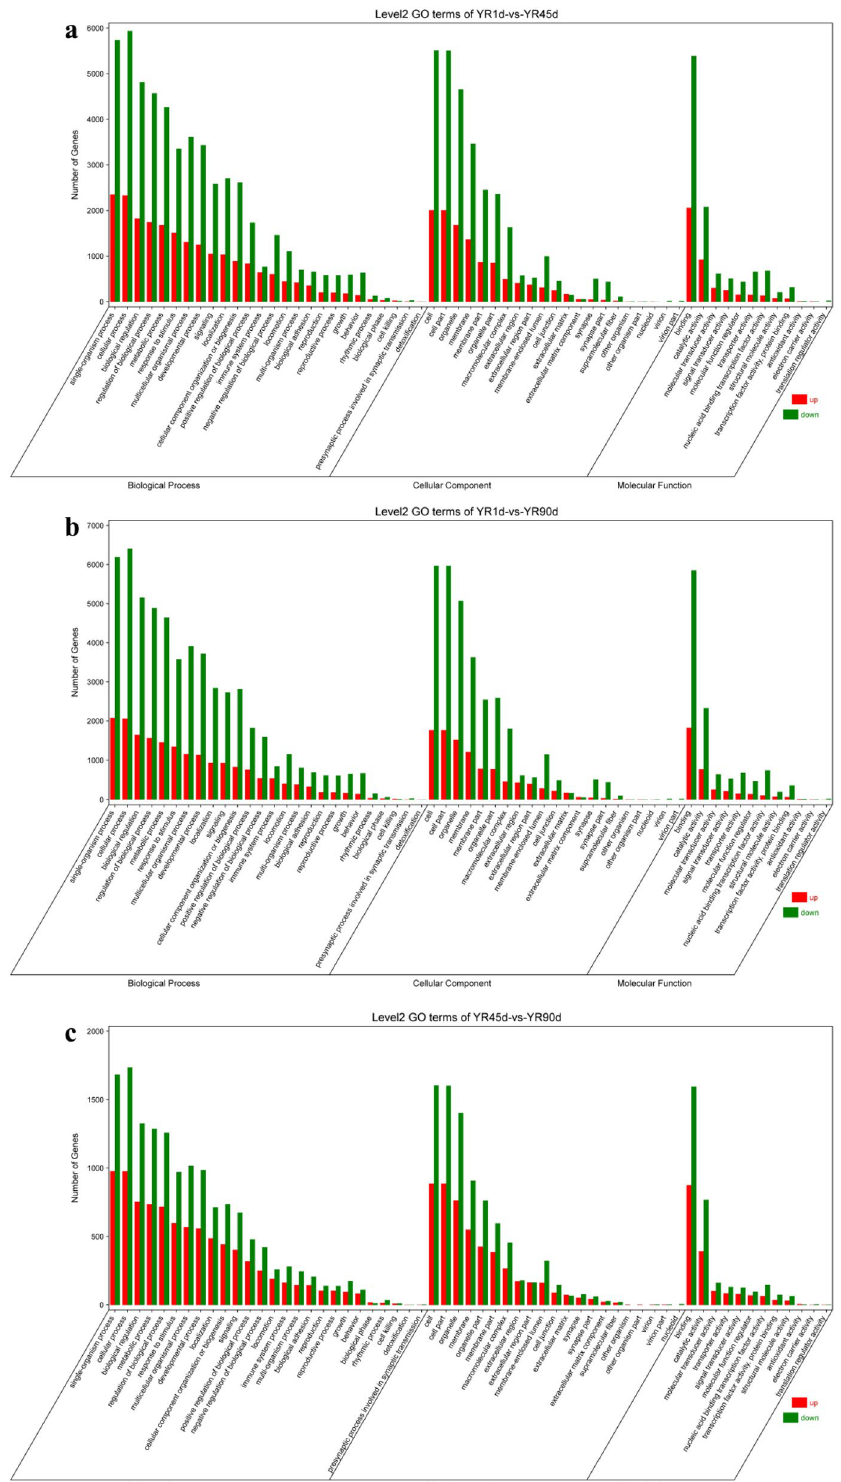
Figure 5. GO categorization of DEGs among the three compared groups. ( a ) YR1d vs. YR45d. ( b ) YR1d vs. YR90d. ( c ) YR45d vs.